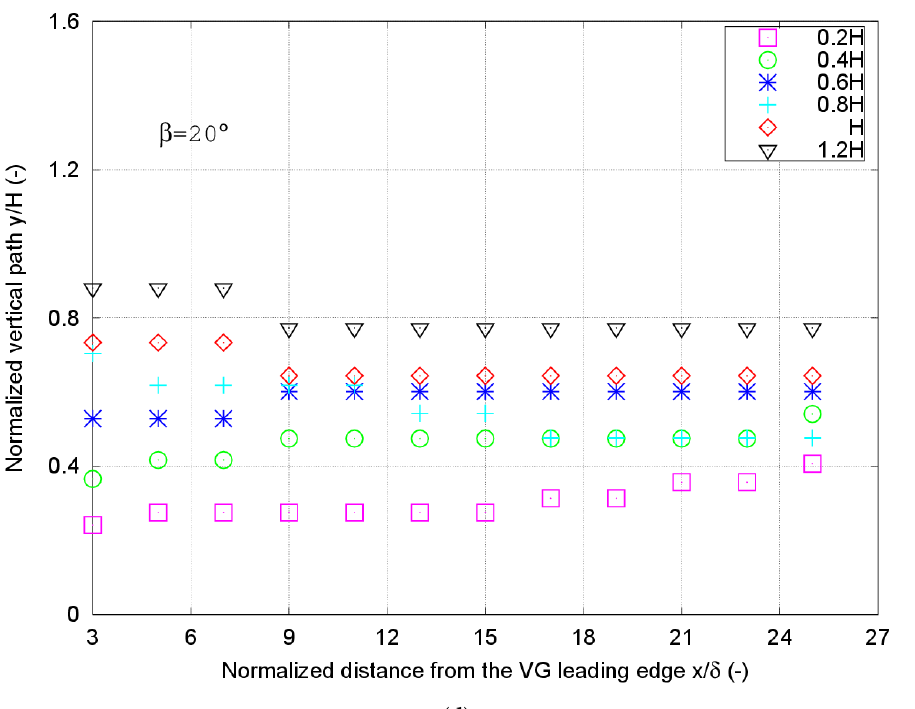
Figure 5. Normalized vertical position of the vortex center as a function of the axial distance x of the VG for six VG heights, 0.2H, 0.4H, 0.6H, 0.8H, H and 1.2H, and four different incident angles, ( a ) β = 10, ( b ) β = 15, ( c ) β = 18, and ( d ) β =